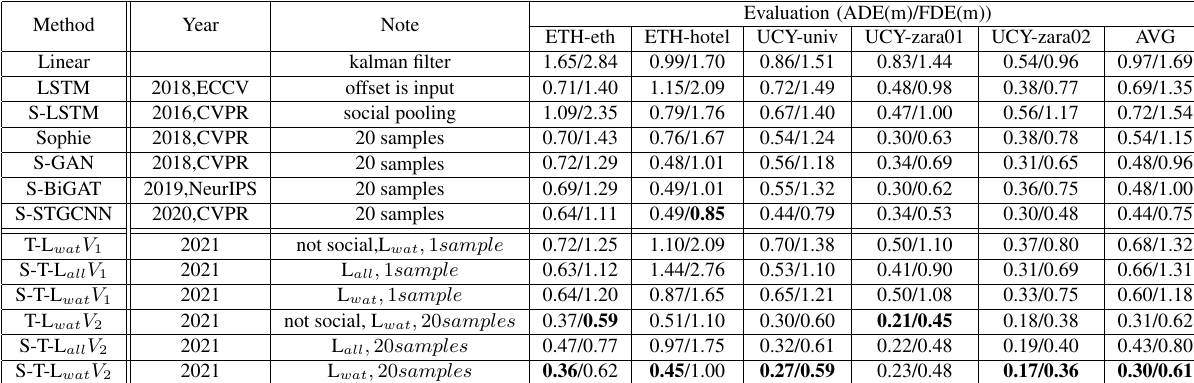
Table 1. Quantitative results of baselines vs. our method across datasets for predicting 12 future timesteps(4.8 sec) given 8 timesteps observation(3.2 sec). The results of S-LSTM, S-GAN are from (Gupta et al., 2018). The results of Sophie are from (Sadeghian et al., 2019). The results of S-BiGAT are from (Kosaraju et al., 2019). The results of S-STGCNN are from (Mohamed et al., 2020).Our model consistently outperforms other baselines (lower is better).